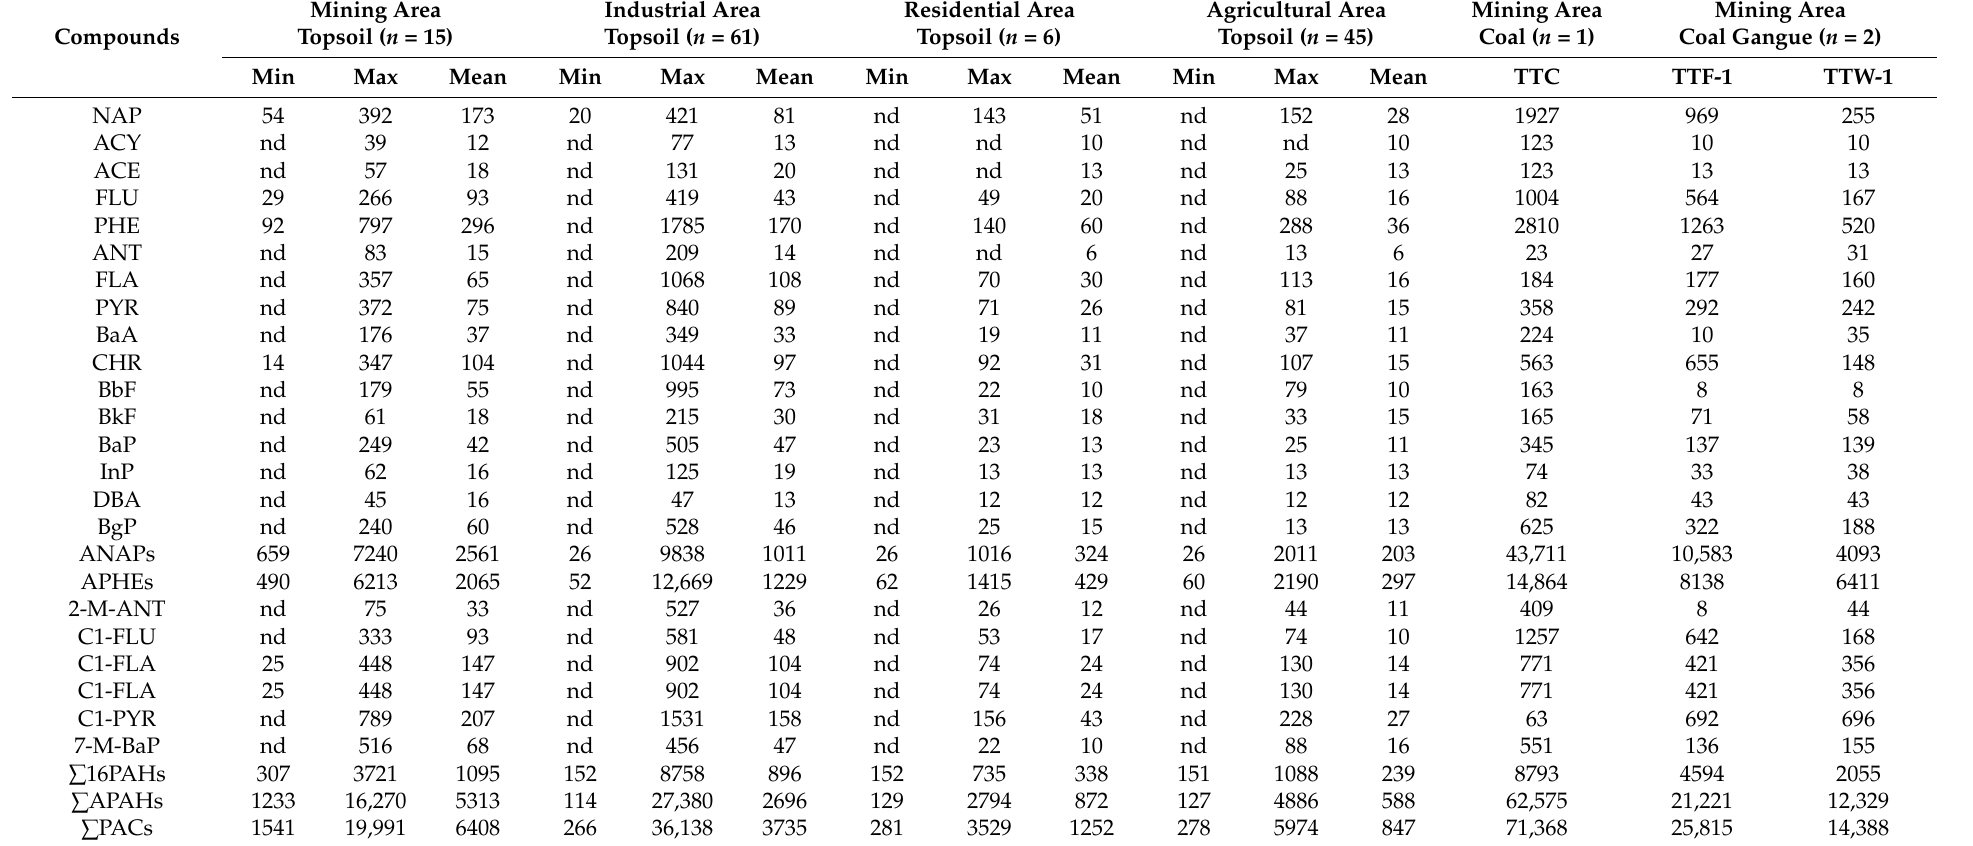
Table 1. PAC concentrations ( µ g/kg) in topsoil from different functional groups and coal and coal